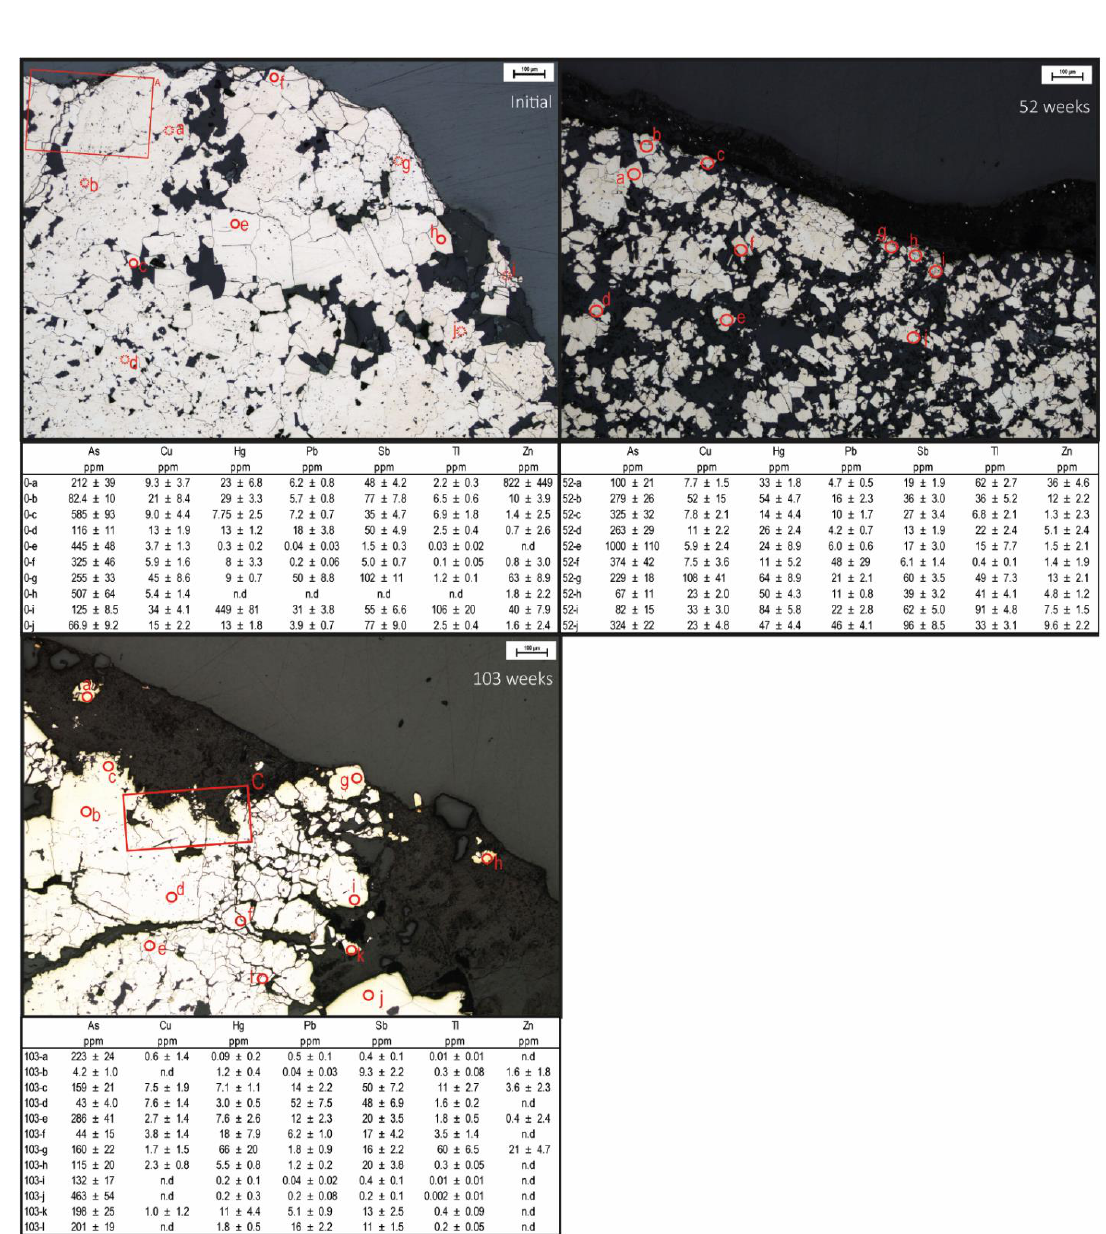
Figure 2. Petrographical microscopic image of pyrite grains in the initial waste rock and after 52 and 103 weeks of leaching. A: Area selected for mapping (Figure 3); C: Area selected for mapping (Figure 3); 0-a-j, 52-a-j, and 103-a-l: LA-ICPMS quantitative element analysis with laser spot size 35 µ m. Spot analysis of crystalline/massive pyrite (initial) is indicated by a smooth circle, and porous/fractured pyrite is indicated by a dashed